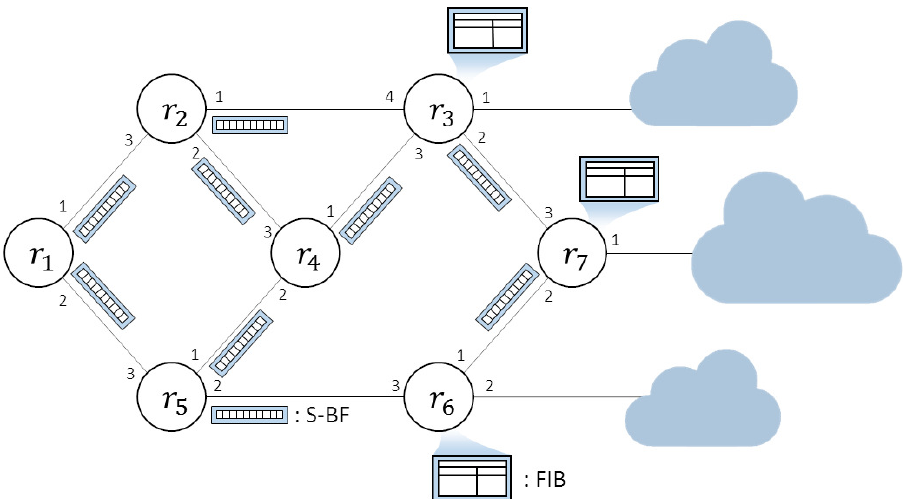
Figure 2. An example of the proposed scheme. The nodes connected to other networks, r 3 , r 6 , and r 7 , only have the FIB table and the connectivity information is carried in